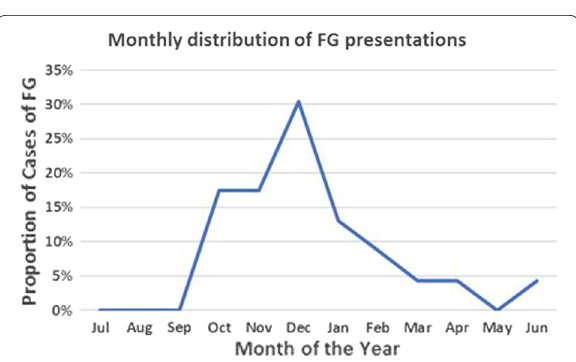
Fig. 2 The monthly distribution of clinical presentations to hospital with Fournier’s gangrene from February 2012 to December